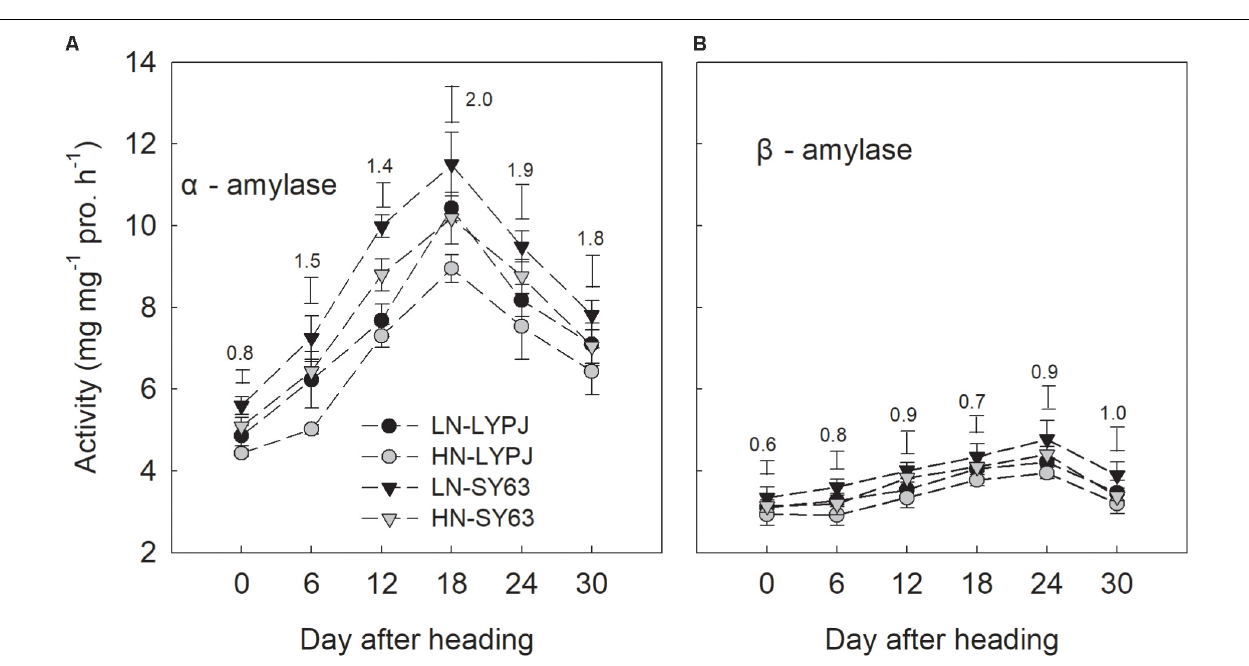
FIGURE 6 | Activities of α -amylase (A) and β -amylase (B) in the stems of LYPJ and SY63 cultivars under LN and HN treatments. Data are shown as mean ± standard error ( n = 3). Vertical bar with number represents LSD 0 . 05 for difference significance of mean among 4 combinations at an identical time